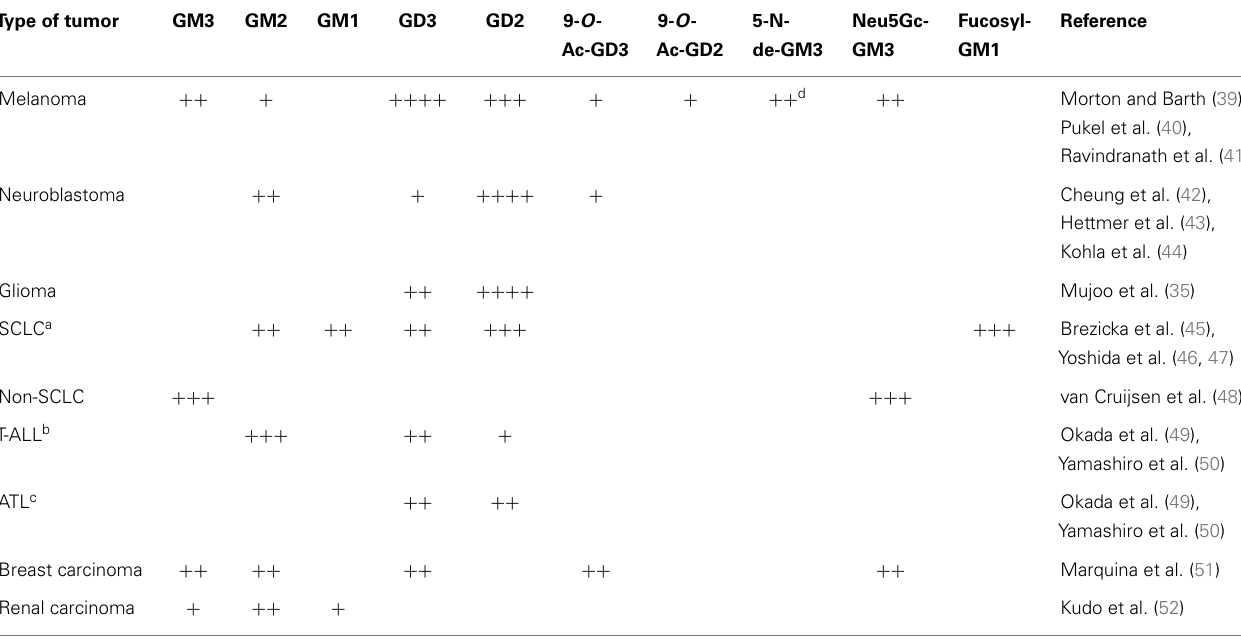
Table 1 | Gangliosides expressed in several types of human cancer